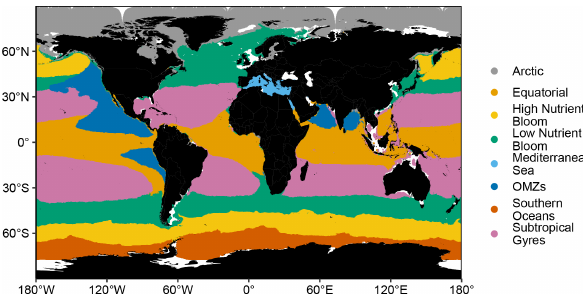
Figure 2. Spatial distribution of the eight BGC regions obtained with a k -means clustering method applied to a data set of modeled climatological monthly time series of the 23 assessment